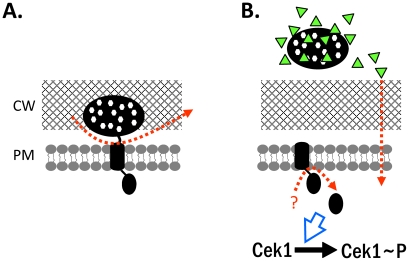
Model for Msb2 functions.The dual function of C. albicans Msb2 protein is shown. The precursor protein (A) is cleaved during growth and the extracellular domain, which is highly O-glycosylated (indicated by white dots), is shed into the medium (B). Msb2 has an intracellular function in activating the Cek1 MAP kinase and the secreted exodomain is able to protect cells against AMPs (triangles).